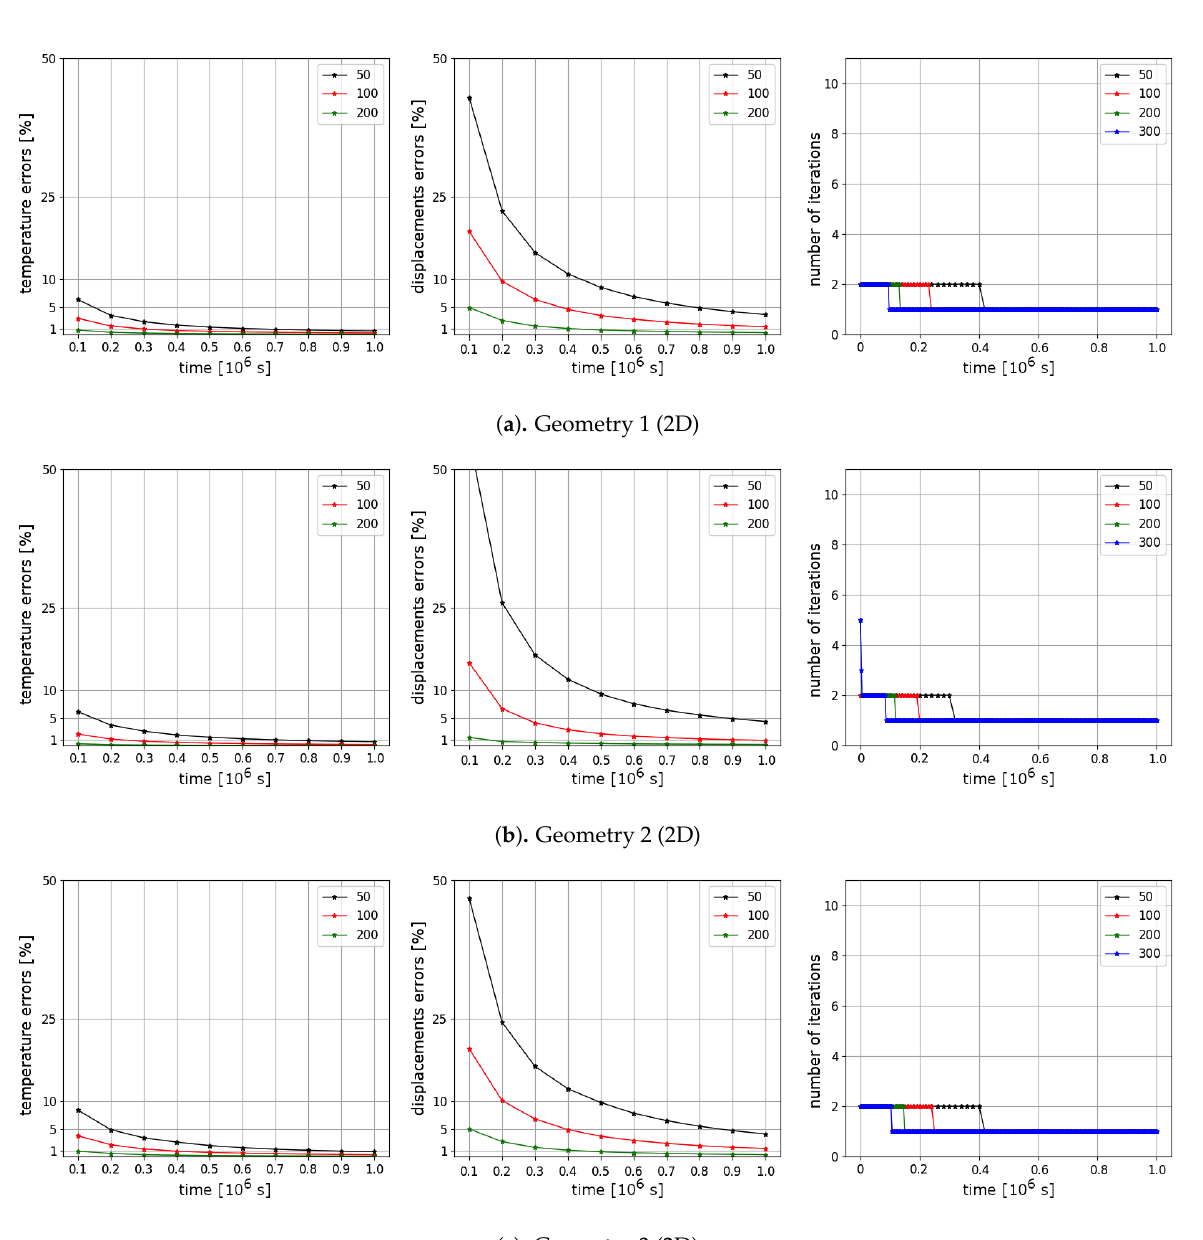
Figure 8. Test 1 for a two-dimensional problem. Results for a solution using Picard iterations with a different number of time steps t m , m = 50,100, 200. Relative errors in % for temperature and displacements for 10 time layers (first and second columns). Number of Picard iterations by time (third